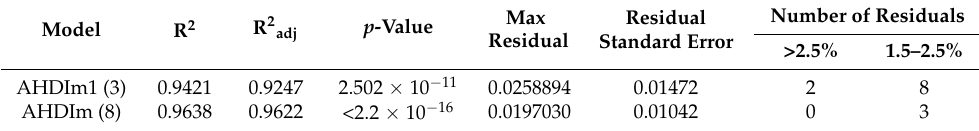
Figure 3. Regularity of linear model AHDIm1 vs. AHDI. Developed by authors. Table 2. Numerical characteristics of linear model AHDIm1 and non-linear model AHDIm.